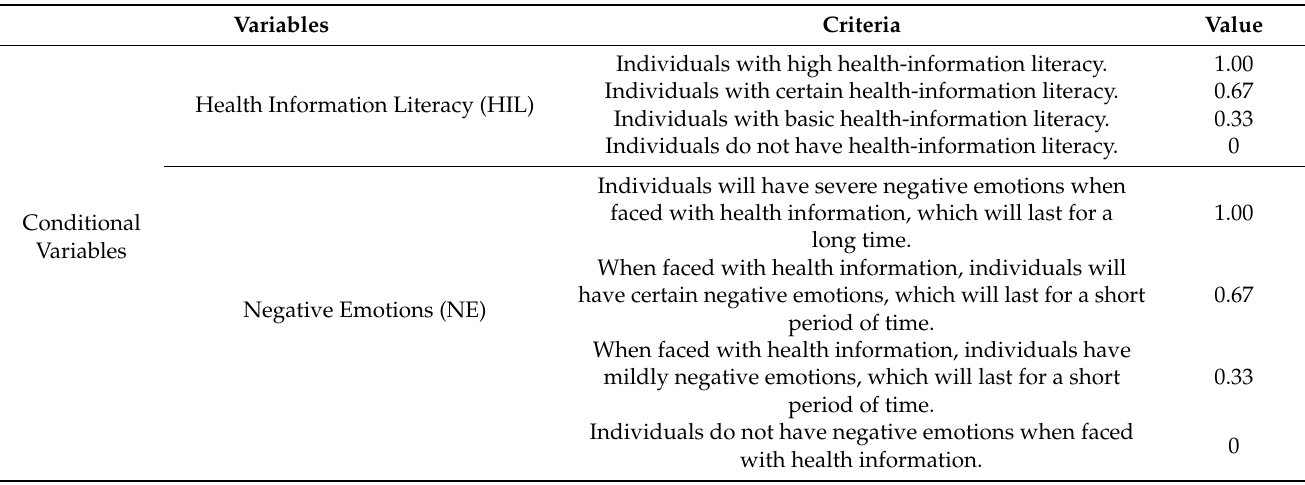
Table 1. The assignment criteria for all